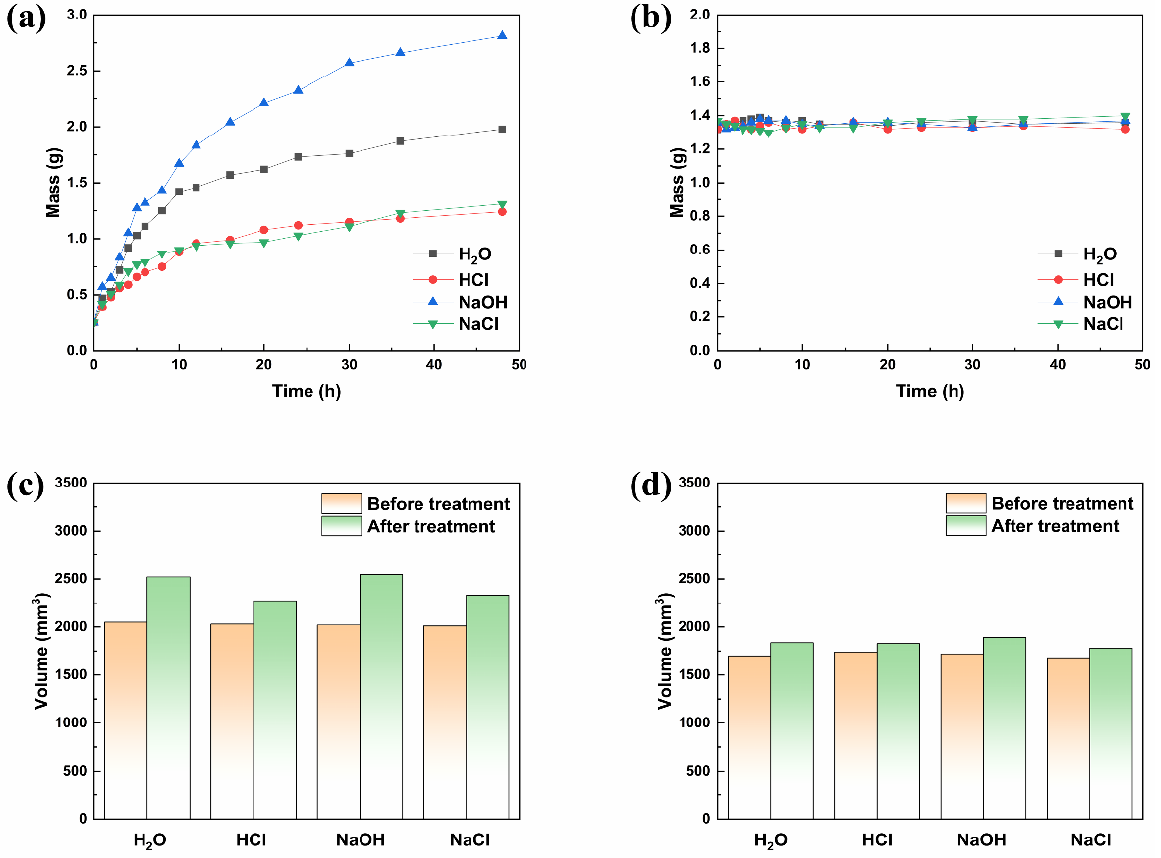
Figure 8. The mass change of ORW in H 2 O, HCl, NaOH, and NaCl ( a ); the mass change of FUW in H 2 O, HCl, NaOH, and NaCl ( b ); the volume change of ORW in H 2 O, HCl, NaOH, and NaCl ( c ); the volume change of FUW in H 2 O, HCl, NaOH, and NaCl ( d ). Corrosion resistance of ORW and FUW was also illustrated in Figure 8, S6 and S7. ORW and FUW were immersed in acid solution, alkali solution, and salt solution, respectively, and the changes in mass and volume were measured. Obviously, whether in acid solution, alkali solution, or salt solution, the mass and volume changes of FUW were smaller than ORW, indicating that FUW had better corrosion resistance than ORW. This was also because the impregnated epoxy resin had good corrosion resistance. Additionally, during the corrosion resistance test, we found that FUW also had a pH-response [32]. Under strong acidic and alkaline conditions, FUW appeared to be light yellow. Under neutral and weak acidic conditions, the color of FUW was dark green. The mechanism and structural changes are demonstrated in Figure